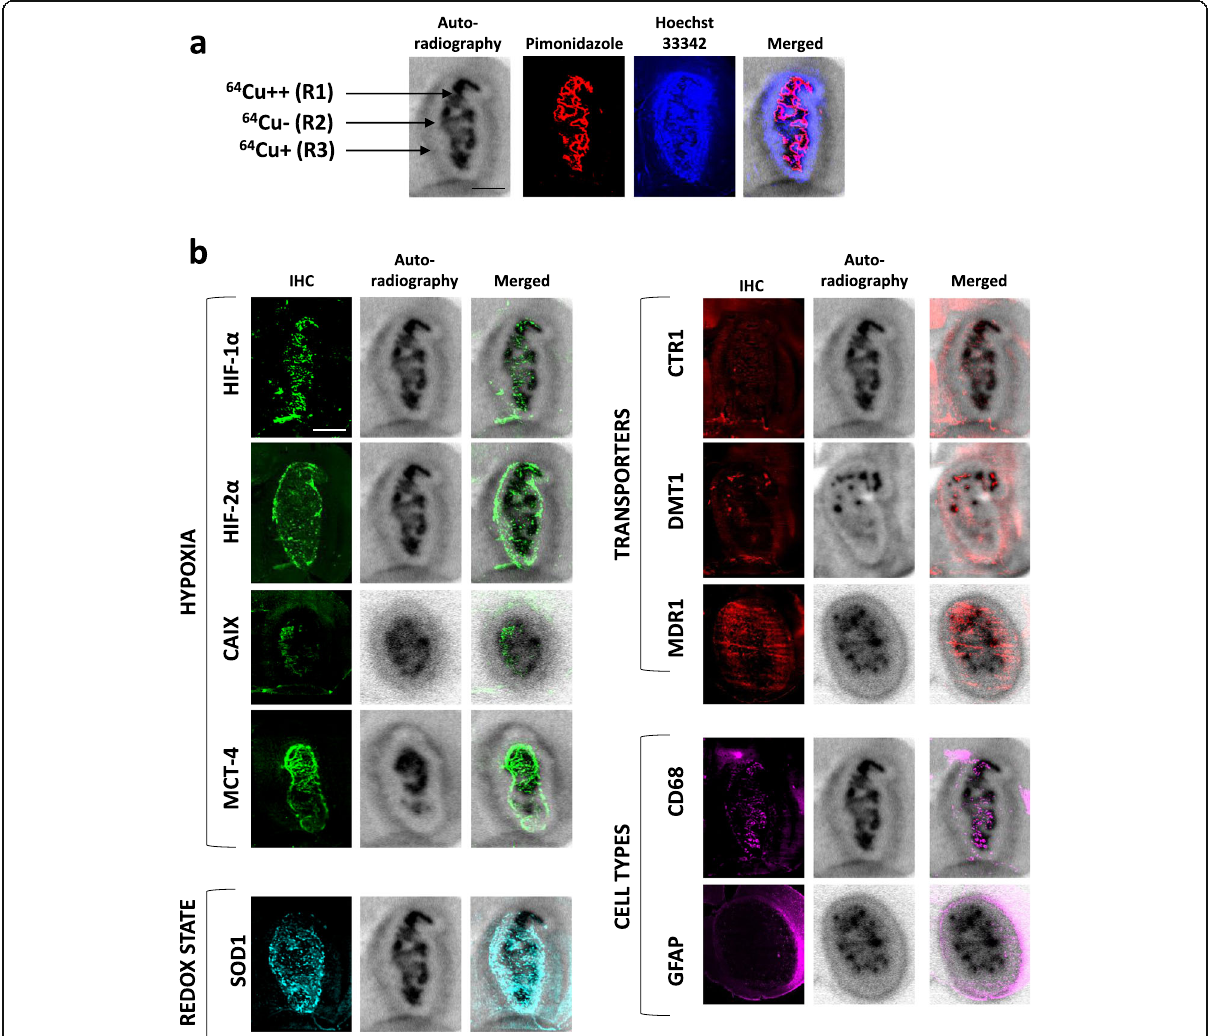
Fig. 4 Relationships between the spatial heterogeneity of 64 Cu uptake and hypoxia and expression of copper transporters. a Three areas with different intensities for 64 Cu were distinguishable on the autoradiography: highly labeled area R1 ( 64 Cu++), an unstaining intermediate region R2 ( 64 Cu − and in the tumor periphery a moderate labeled region ( 64 Cu+). Autoradiography was co-registered with pimonidazole staining to evaluate severe hypoxia and also Hoechst 33342 nucleic acid stain to identify the tumor mass. Scale bar = 200 μ m. b Representative immunostaining of hypoxia markers (HIF-1 α , HIF-2 α , CAIX, MCT-4), specific or non-specific copper transporters (CTR1, DMT1, and MDR1), redox state (SOD1), and different cell types (CD68 for monocytes/macrophages and GFAP for reactive astrocytes). The autoradiography and immunohistochemistry studies were performed on same animals and consecutive sections. Scale bar = 200 μ